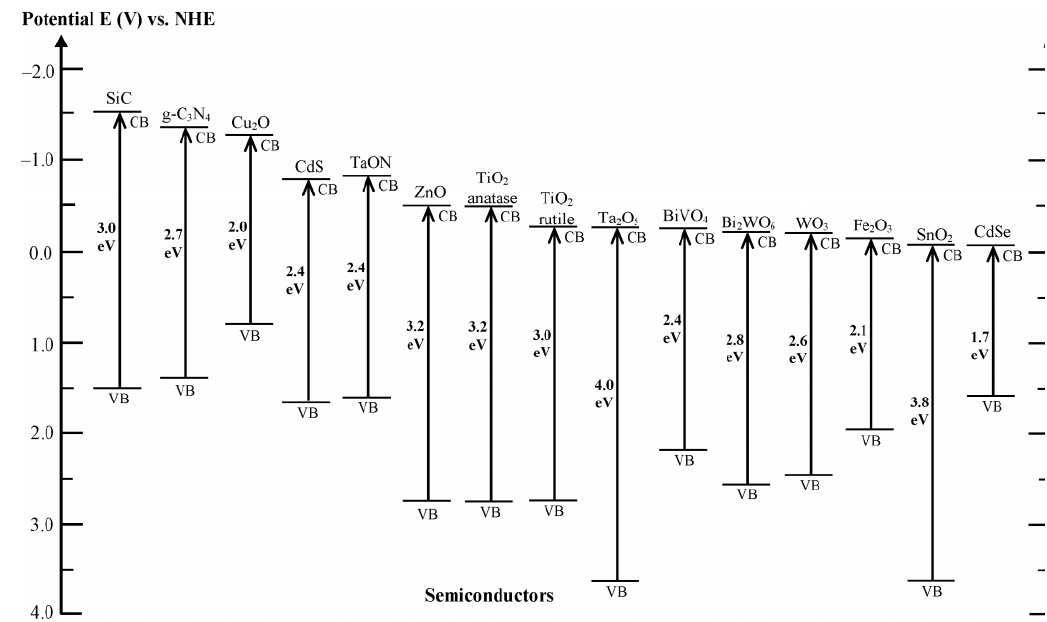
Figure 3. Redox potential and band gap energies of some selected semiconductor photocatalysts at pH 7. Reprinted with permission from [43], Copyright (2016) American Chemical Society.